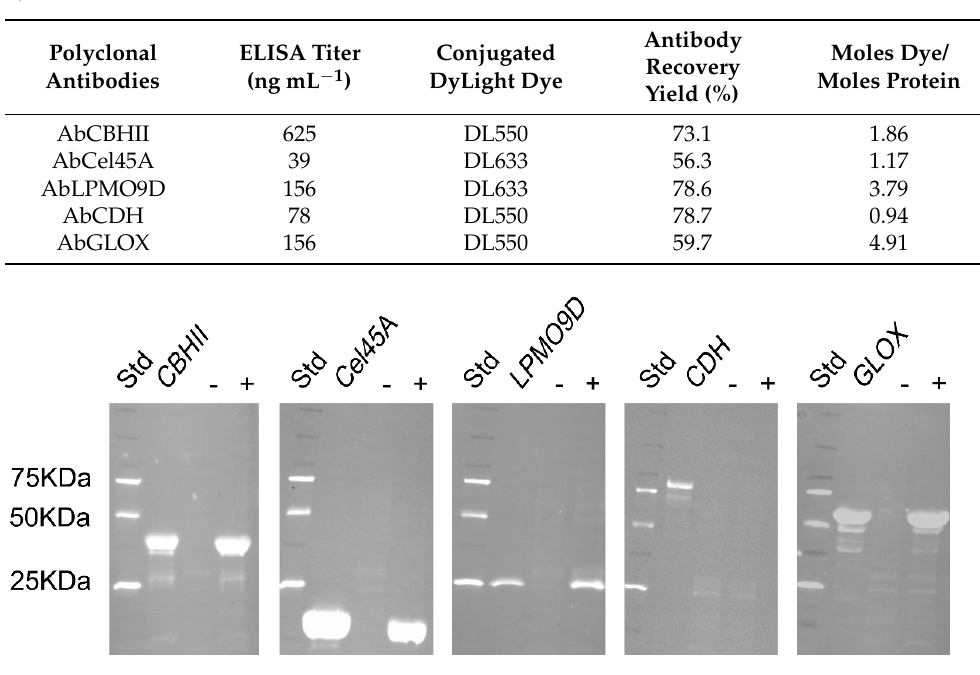
Figure 1. Western blot analysis of conjugated rabbit polyclonal antibodies with DyLight dyes against P. chrysosporium hydrolases and oxidoreductases. Std lane corresponds to the Precision Plus Protein WesternC standard ladder (Bio-Rad, Hercules, CA, USA). P. chrysosporium culture super- natant after ~7 days of fermentation showing no detectable activity of the investigated enzymes was used as a negative control ( − ). The culture supernatant was supplemented with the targeted enzyme and was used as a positive control (+). Conjugated antibodies (1:5000) were incubated in PBS supplemented with 1% BSA for 2 h at 21 °C and washed for 5 min each in PBS containing 0.1% (v/v) Tween 20 3 times. Antibody binding was detected by exciting the membrane with Cy 2 and Qdot 625 excitation/ emission settings corresponding to DyLight D550 (CBHII; CDH; GLOX) and DyLight D633 (Cel45A, LPMO9D) respectively.